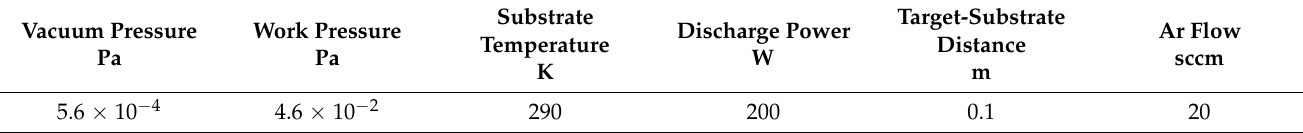
Table 1. Summary of deposit conditions for coatings growth.